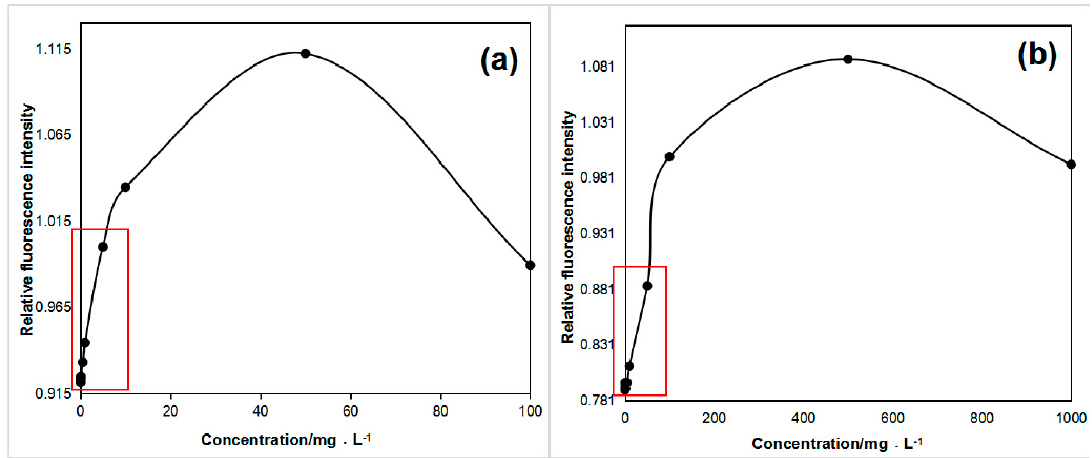
Figure 8. Fluorescence quenching of ( a ) tryptophan and ( b ) tyrosine.